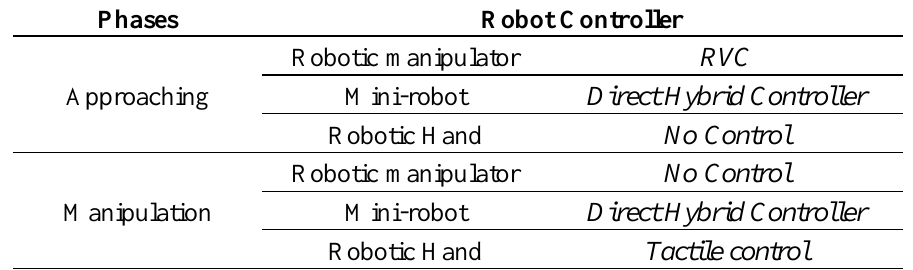
Table 1. Phases and control used by each one of the robotic systems in the proposed